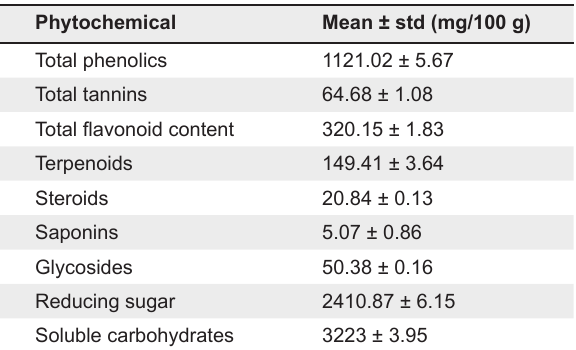
Quantitative phytochemical analysis of